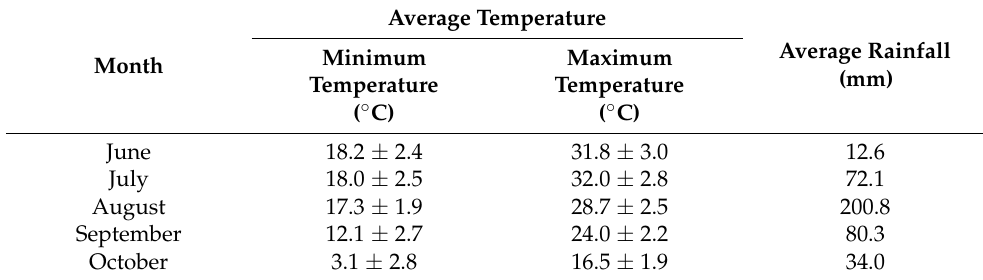
Table 2. The mean monthly temperature and precipitation at experimental